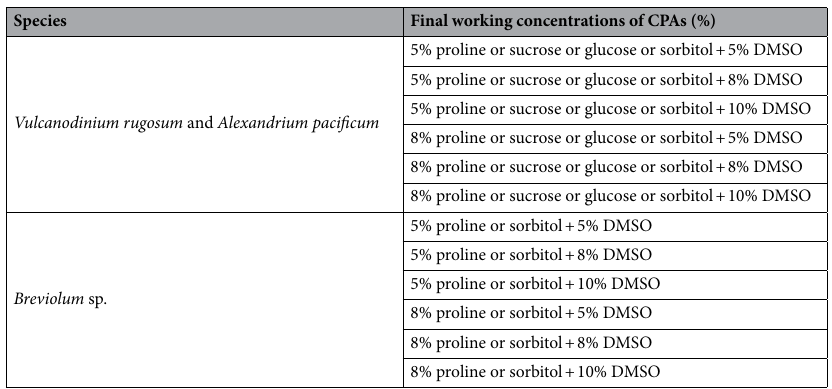
Table 1. Treatment tests using combinations of two cryoprotective agents (CPAs) on the three different dinoflagellate